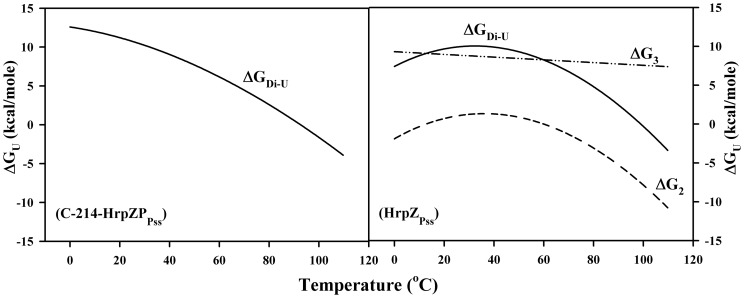
Conformational stability curves of C-214HrpZPss and HrpZPss.Solid lines correspond to dimer - unfolded state transition (ΔGDi-U). Values of ΔG2 and ΔG3 for HrpZPss corresponding to transition 2 and 3 were calculated using equations 1 and 2 (see text for more details).